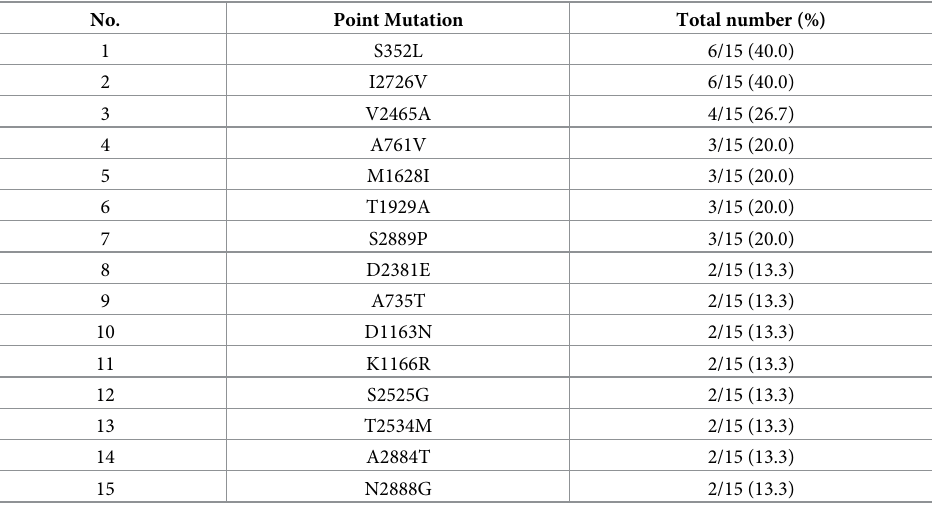
Table 5. The frequency of the 15 most common mutations in rpoB . No. Point Mutation Total number